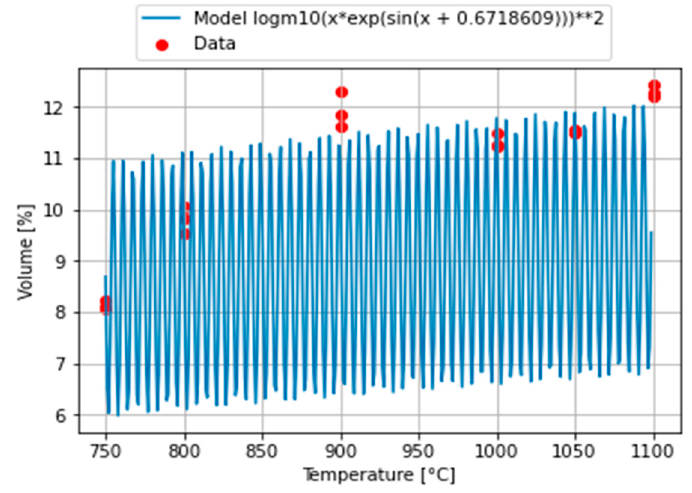
Figure 6. Model 1 of carbon dioxide CO 2 .